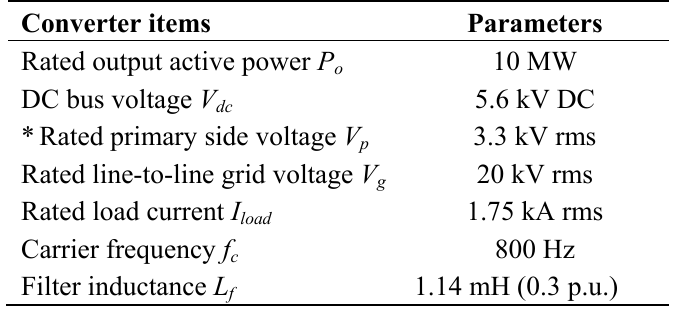
Table 2. Rated parameters of 10 MW 3L-NPC wind power inverter for case